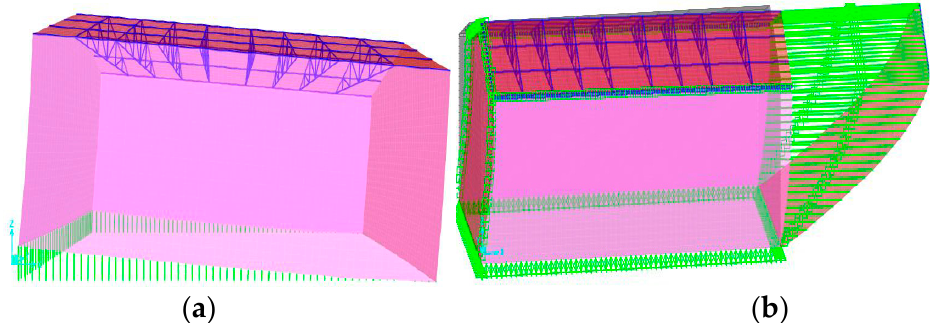
Figure 19. ( a ) Non-linear links to simulate uplifting of the structure at the soil-foundation interface; ( b ) Non-linear links to simulate detachment between the roof and the masonry walls or between vertical walls at the corners.